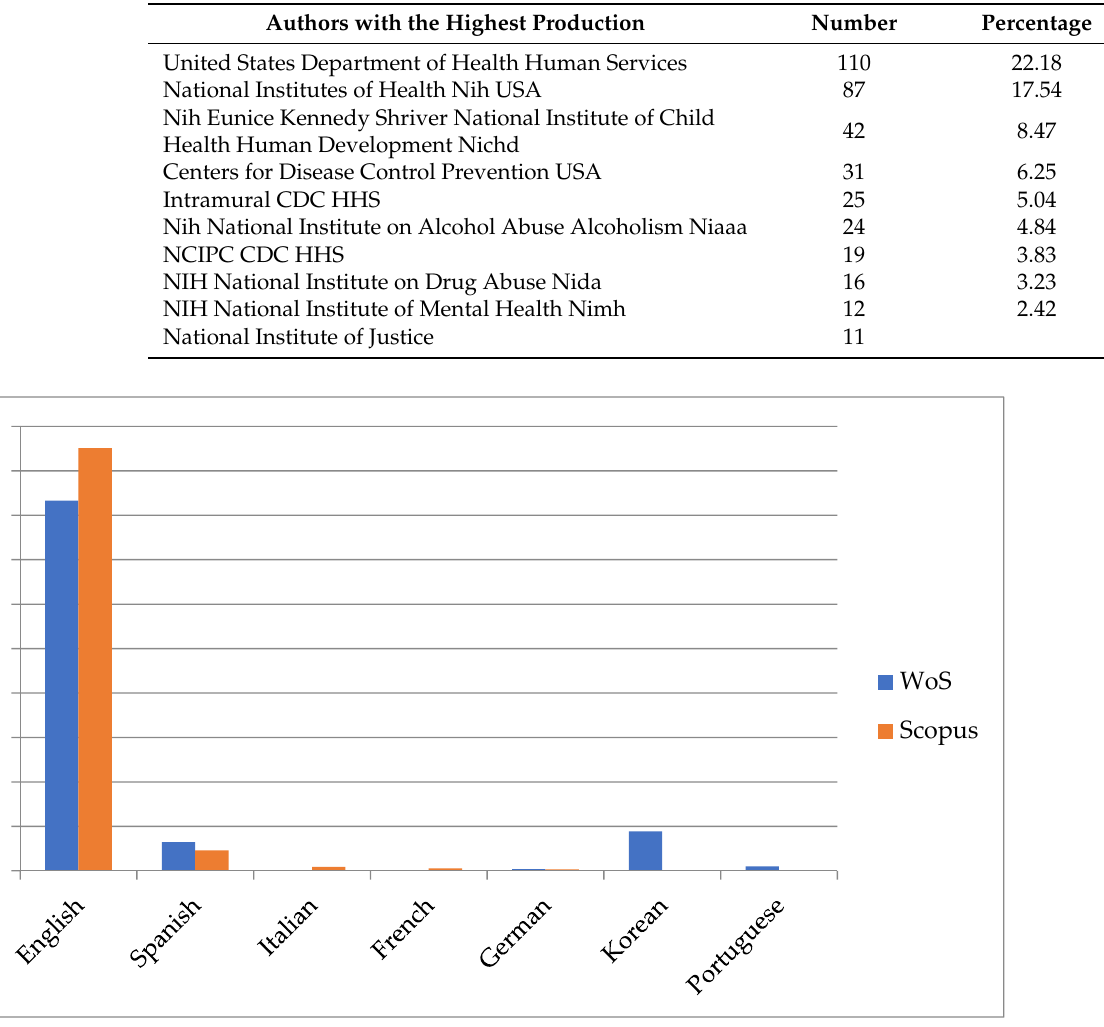
Table 3. Number of documents by affiliation found in the WoS database.